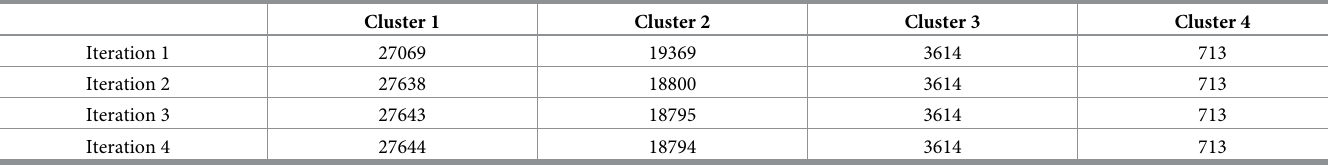
Table 6. Cluster memberships over